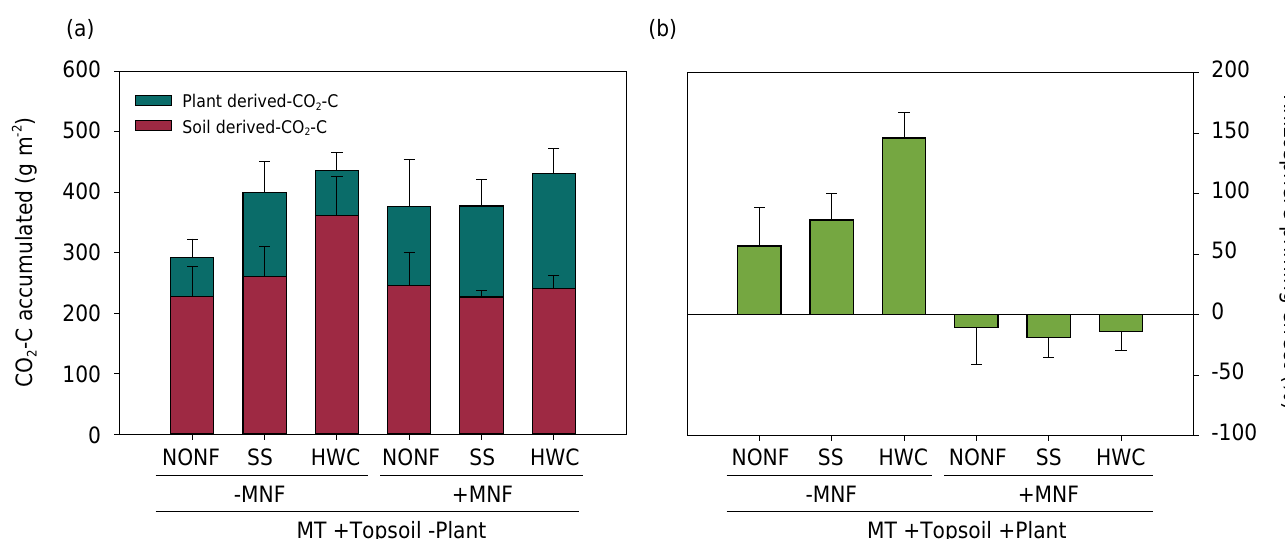
Figure 5. Plant derived-CO 2 -C and Soil derived-CO 2 -C accumulated (g m -2 ; a) and Rhizosphere priming effect (%; b) 78 days after sowing in iron mining tailing + topsoil (MT + Topsoil), with (+Plant), without (-MNF) and with mineral-N fertilization (+MNF) and different organic-N fertilization (non-organic-N fertilization, sewage sludge – SS, and household waste composting - HWC). Vertical bars represent the means ± 90 % confidence interval (n =